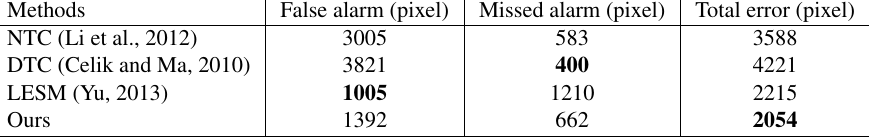
Table 2: Quantitative comparison on Sardinia